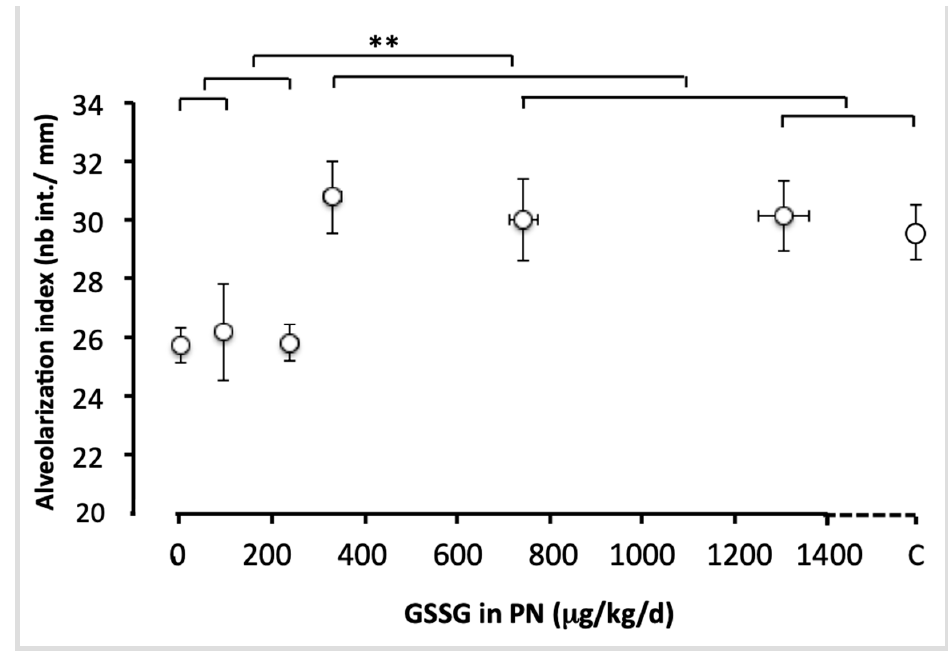
Figure 6. Alveolarization index as a function of increasing doses of GSSG added to PN. The control (C) value was added to the abscissa after the highest dose of GSSG. The orthogonal comparisons were 0 vs. 95 µg/kg/d (no statistical difference), both vs. 240 µg/kg/d (no difference). Among the highest doses, 1300 µg/kg/d were not statistically different from the control, the two were not different from 750 µg/kg/d nor from 330 µg/kg/d. The highest doses (330 to 1300 µg/kg/d) and the control were statistically different (F (1.40) = 18.1, p < 0.0001) from the lowest doses (0 to 240 µg/kg/d). Mean ± S.E.M. for alveolarization indexes ( y axis) and doses ( x axis). The bars indicate the orthogonal comparisons; the absence of significant difference is shown by the absence of symbol above the bar; **: p < 0.0001; n = 6–11 per group. GSSG levels are dependent on glutathione peroxidase (GPx) and reductase (GR). Thus,